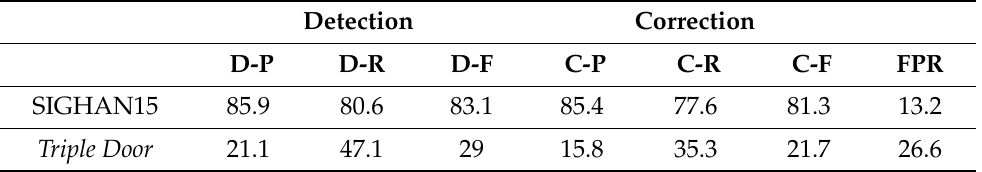
Table 1. CRC results of SpellGCN on Triple Door at character level. P, R, F represent Precision, Recall, and F1 score. We also give the correction’s False Positive Rate (FPR) at the sentence level. The FPR value represents the rate of false, corrected sentences to the total number of correct